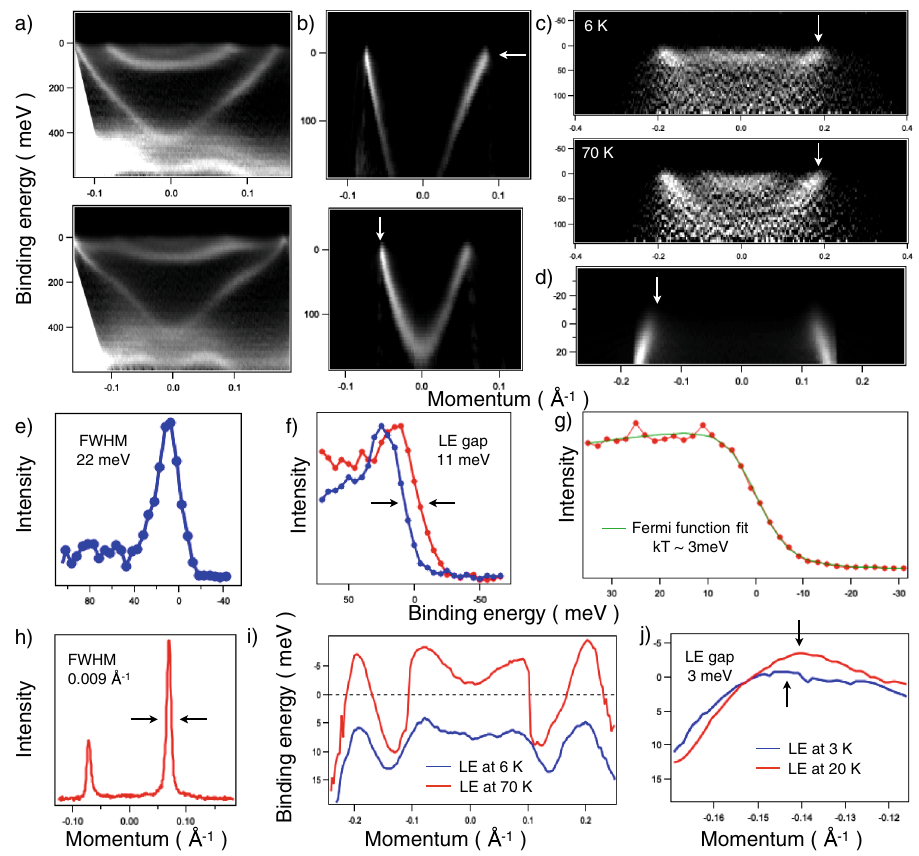
Fig. 5 Energy direction and resolution. a Momentum-energy cuts along the high-symmetry Γ K- and Γ M- directions of Bi 2 Te 3 extracted from the differential scans shown in Fig. 4 and converted to the momentum scale. Laser, 6 eV. T = 3 K. Energy step − 10 meV. b Same as a , but taken earlier after cleavage and with energy step of 5 meV. c Dispersion along the cut through the antinodes in BSCCO above and below superconducting transition ( T c ~ 65 K). Synchrotron, 24 eV. Energy step − 5 meV. Acquisition time of the whole 3D dataset ~20 min. Noise is due to variations of the ring current, which were not recorded and considered. d Vertical cut through the smallest FS of LiFeAs (Fig. 3c, 20 K). Energy step − 2 meV. e EDC corresponding to white arrow in b . f EDCs corresponding to white arrows in c and integrated within ~0.05 Å − 1 window. g Background EDC from the momentum location shown by white arrow in d shortly after k F so that the spectrum looks like a Fermi edge. It is integrated within 10×10 pixels of the camera from the 500×500 dataset. There are 34 layers in this particular 3D wave — the energy steps taken every 2 meV. Each layer took 20 seconds to record. T = 3 K. h MDC from b . i Leading edge midpoints of the EDCs from c . j Leading edge midpoints from some of the EDCs in d